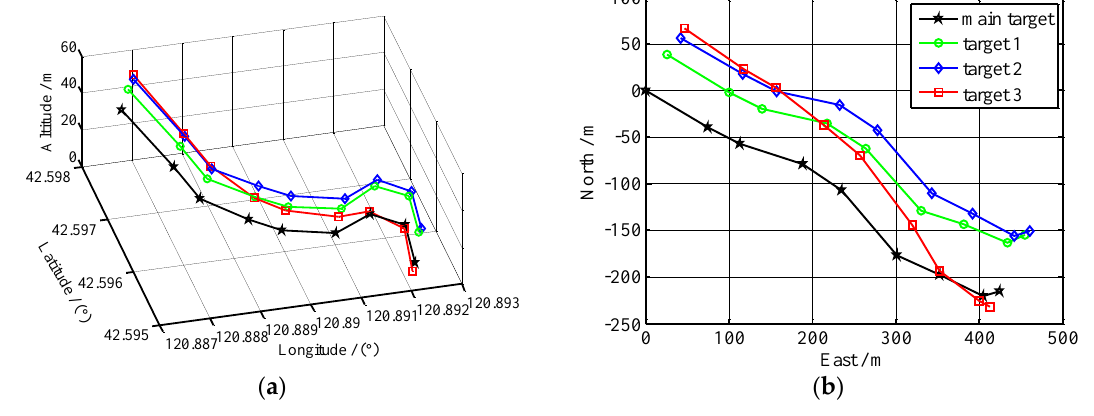
Figure 17. ( a ) The spatial localization of each target; ( b ) The target motion trajectory on the ground.